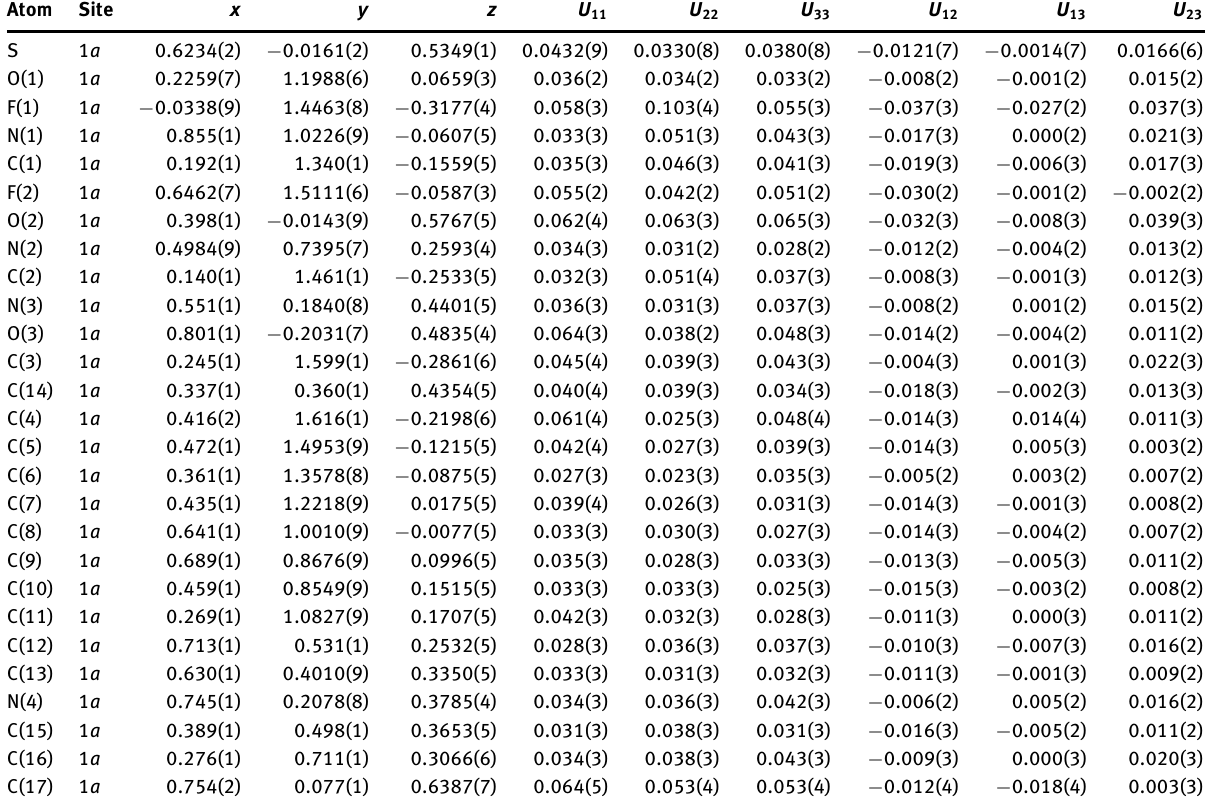
Table 3: Fractional coordinates and atomic displacement parameters (Å 2